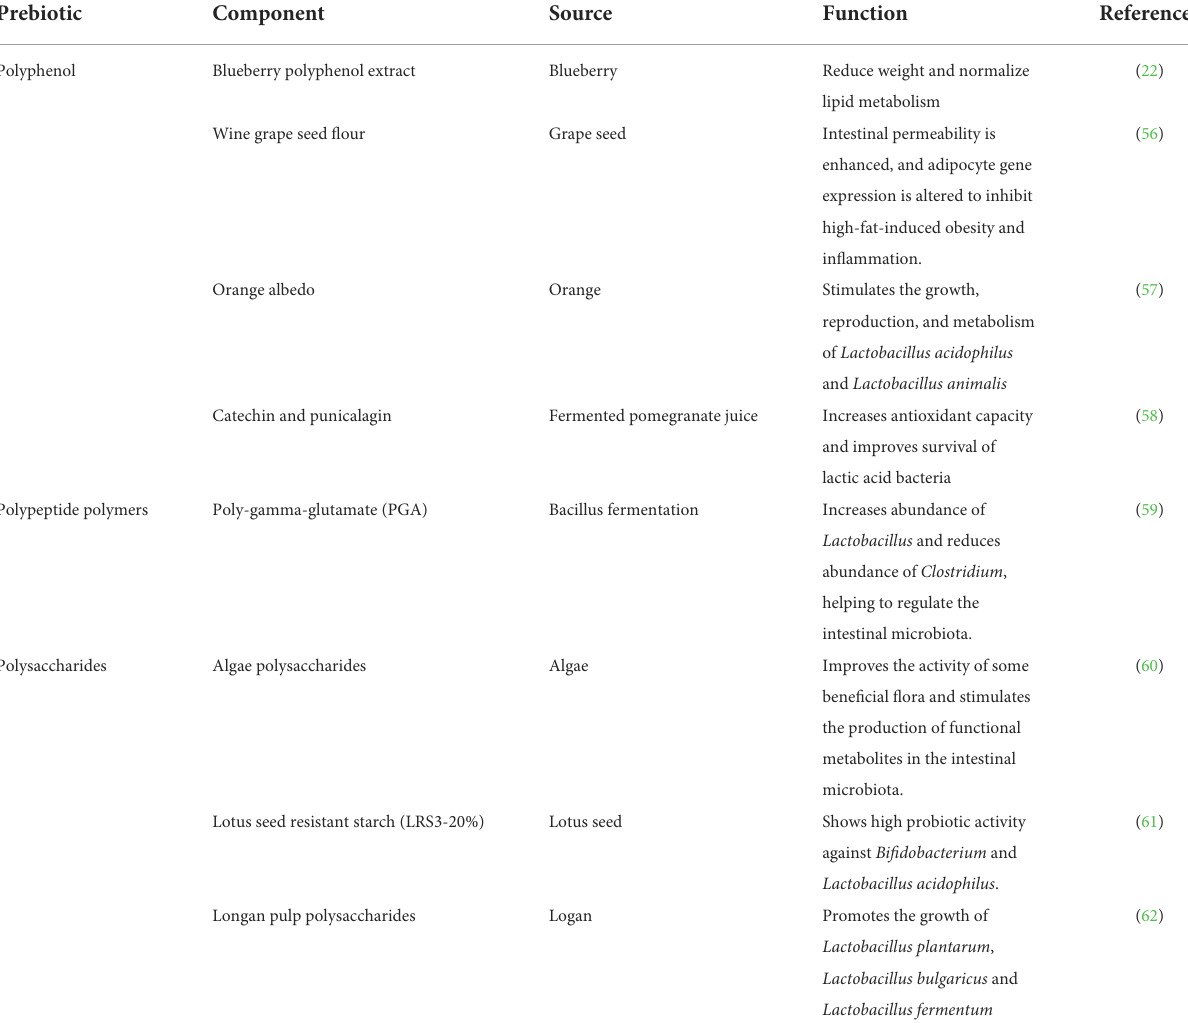
TABLE 1 Different kinds of emerging